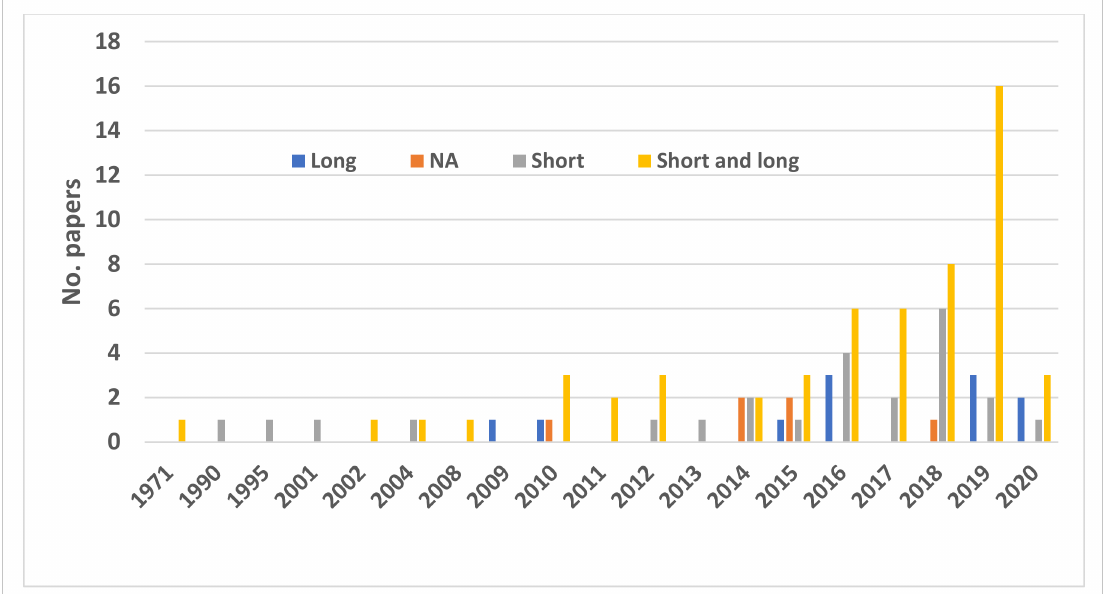
Figure 6. Papers considering short- and long-term effects of ocean acidification on fishes. NA indicates that the timescale of the effect was not